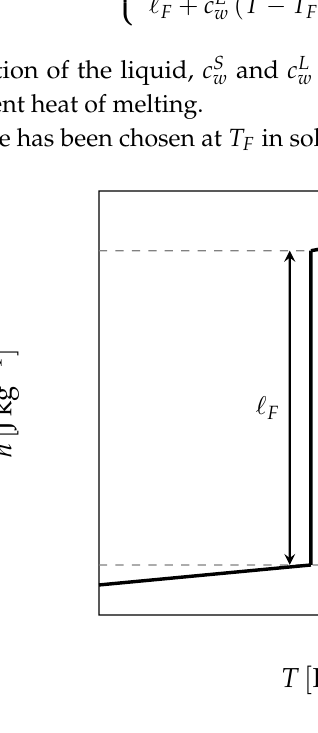
Figure 7. Specific enthalpy for a pure Figure 6: Specific enthalpy for a pure substance